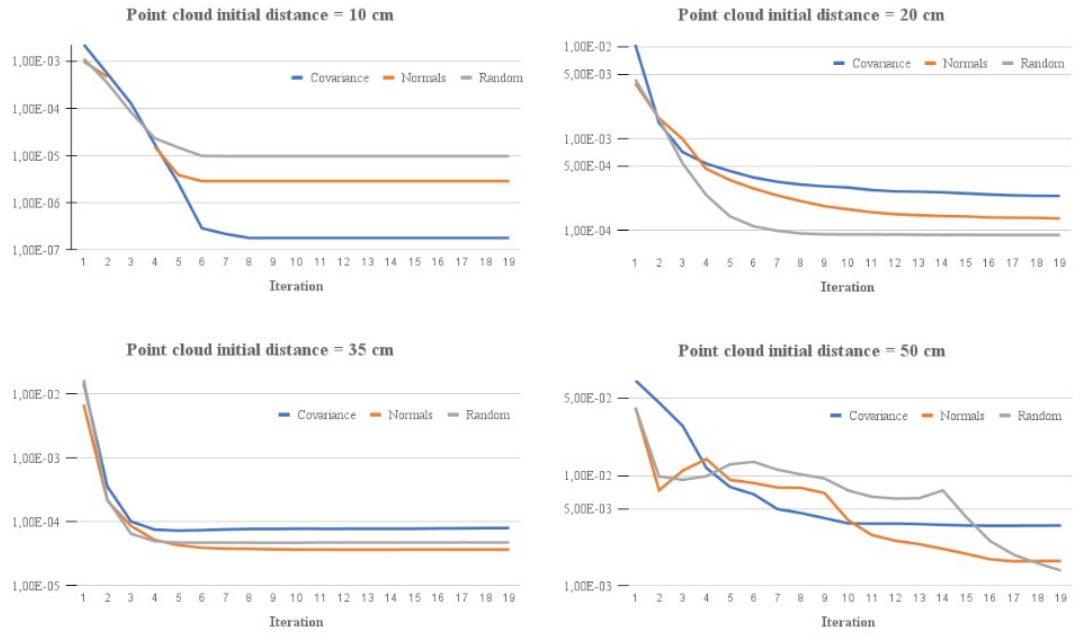
Figure 2. Sampling method comparison for different point cloud distances. Algorithm 1